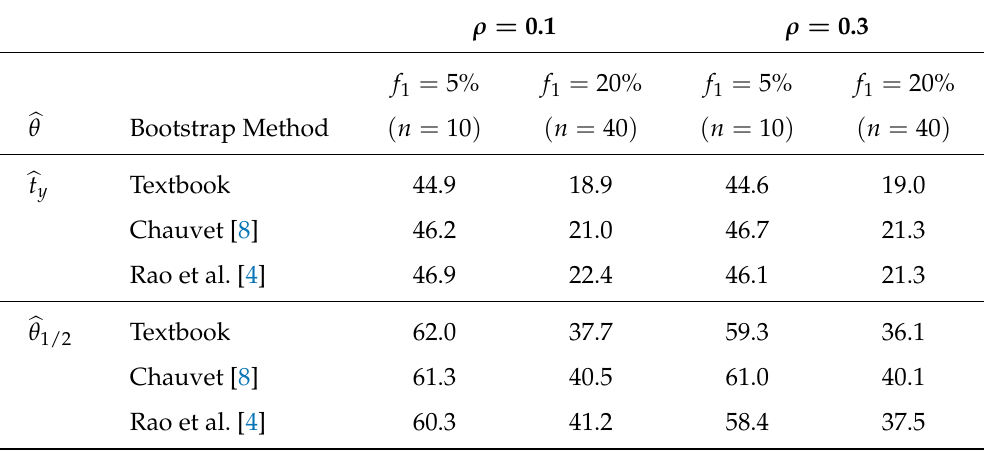
Table 7. Monte Carlo percent CV based on 3000 samples selected according to IPPS/SRSWOR.